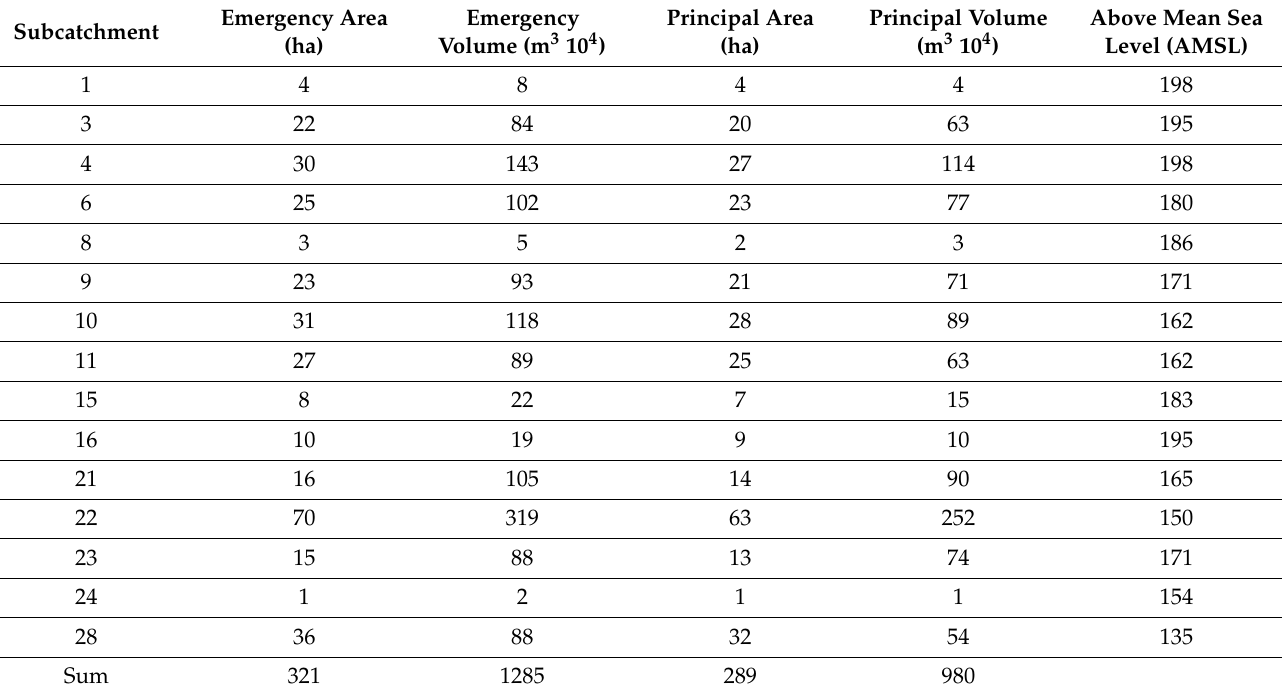
Table 3. Areas and volumes of modified or designed reservoirs for adaptation scenarios 1–5 in